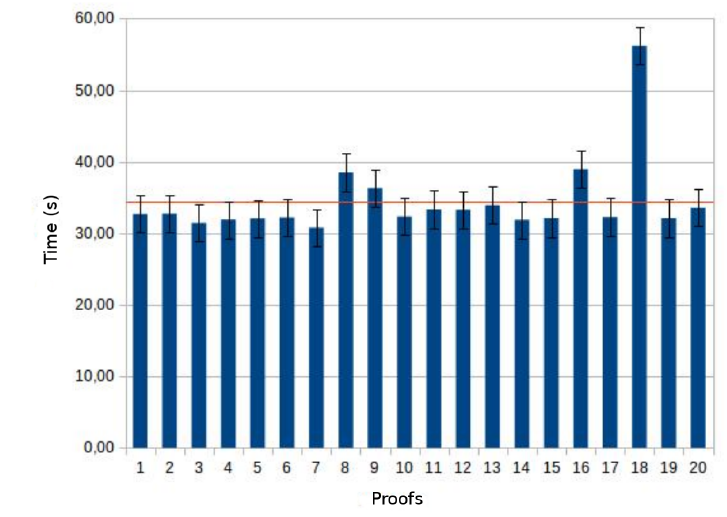
Figure 6. collect action for 2.5 GB file. 20 proofs average and confidence interval equal to 95%.